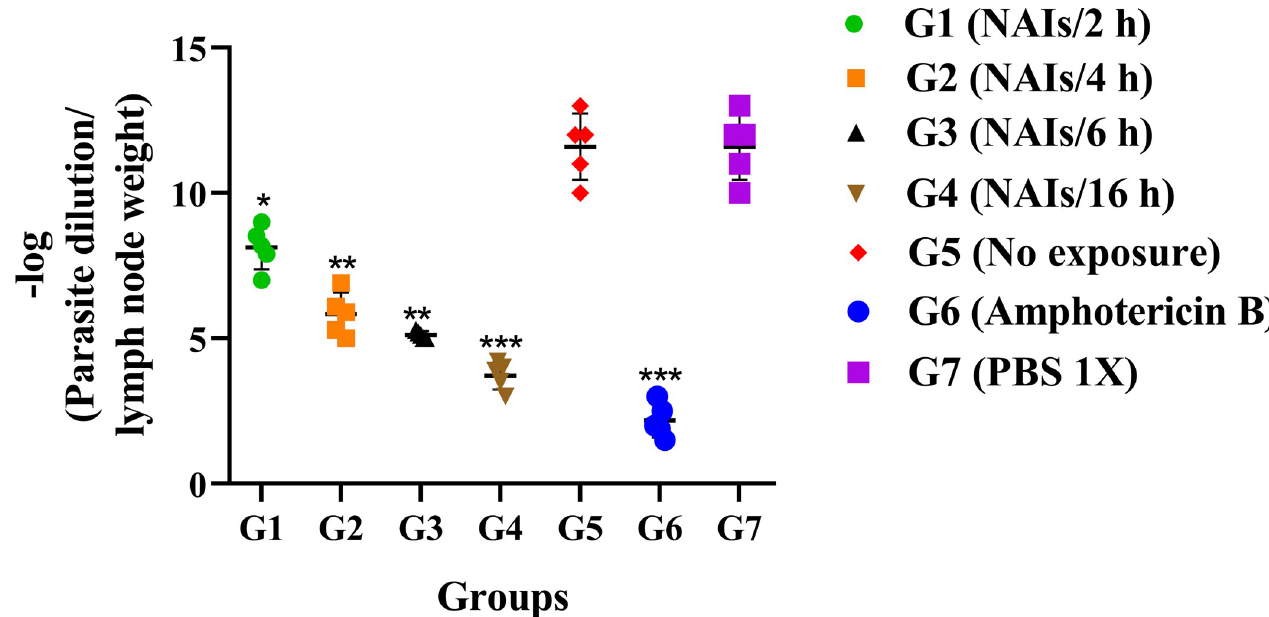
Fig 4. Leishmania major parasite loads in the draining inguinal lymph nodes (LNs) of different mice groups following NAIs therapy at six weeks post CL infection by using conventional limiting dilution assay (microtitration) (after the end of treatment, five mice from each group were randomly selected). All data are reported as the mean ± SD, five mice per group. Data of one out of three independent experiments is shown, all three presenting similar outcomes ( � P < 0.05, �� P < 0.01, ��� P < 0.001).